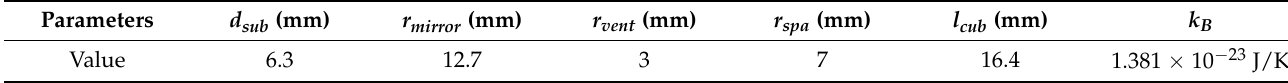
Table 1. Parameters used for estimation and simulation.